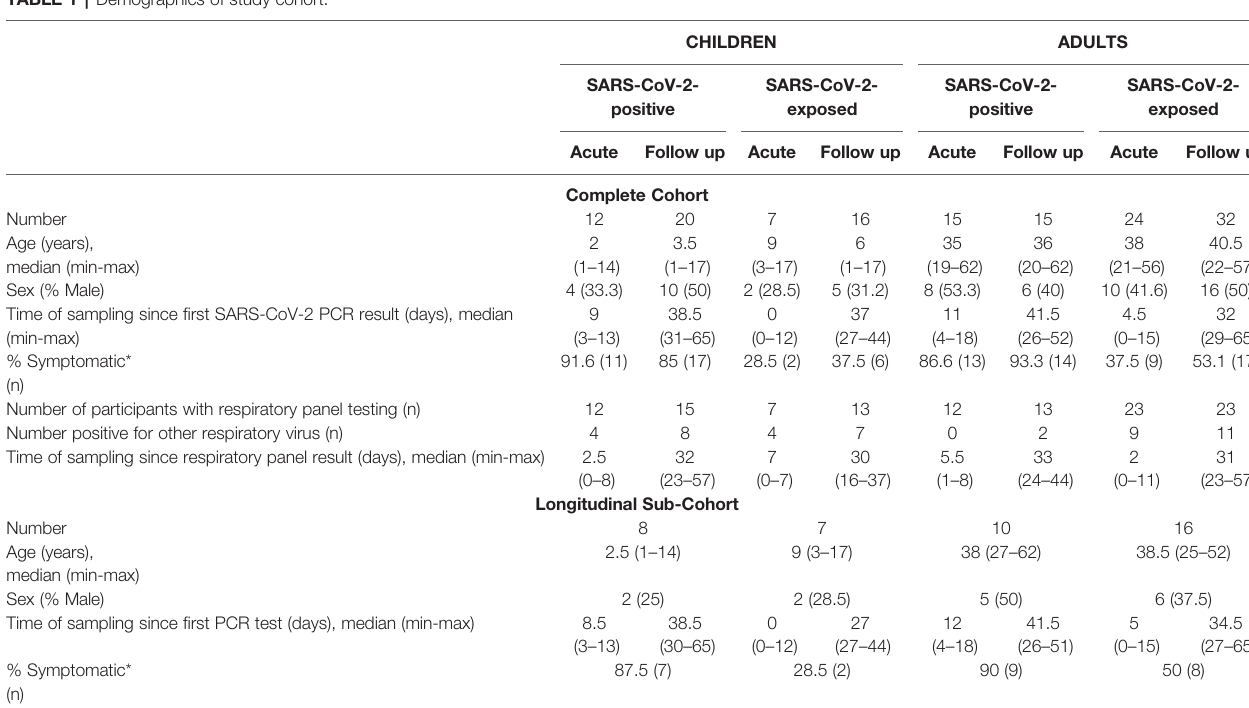
TABLE 1 | Demographics of study